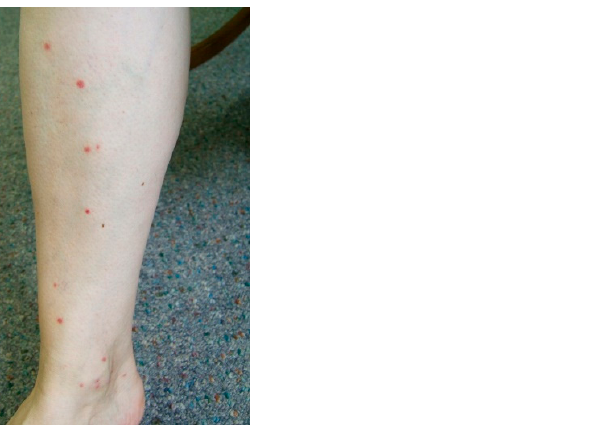
Figure 3. A few red papules on the lower limb of a 54-year-old woman after the blackfly bites. The patients were usually attacked by a large number of blackflies simultaneously. In total, 313 bites were detected on upper limbs. A lower number of blackfly bites (248) were noted on various parts of the lower limbs of the patients (Table 2). Table 2. Localization of blackfly bites in the patients ( n = 671).